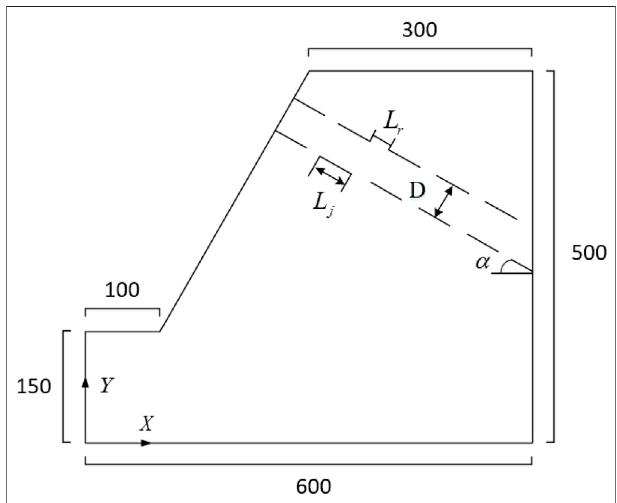
FIGURE 3 | Diagram of the model dimension and nonpersistent joint in the slope (unit: m).